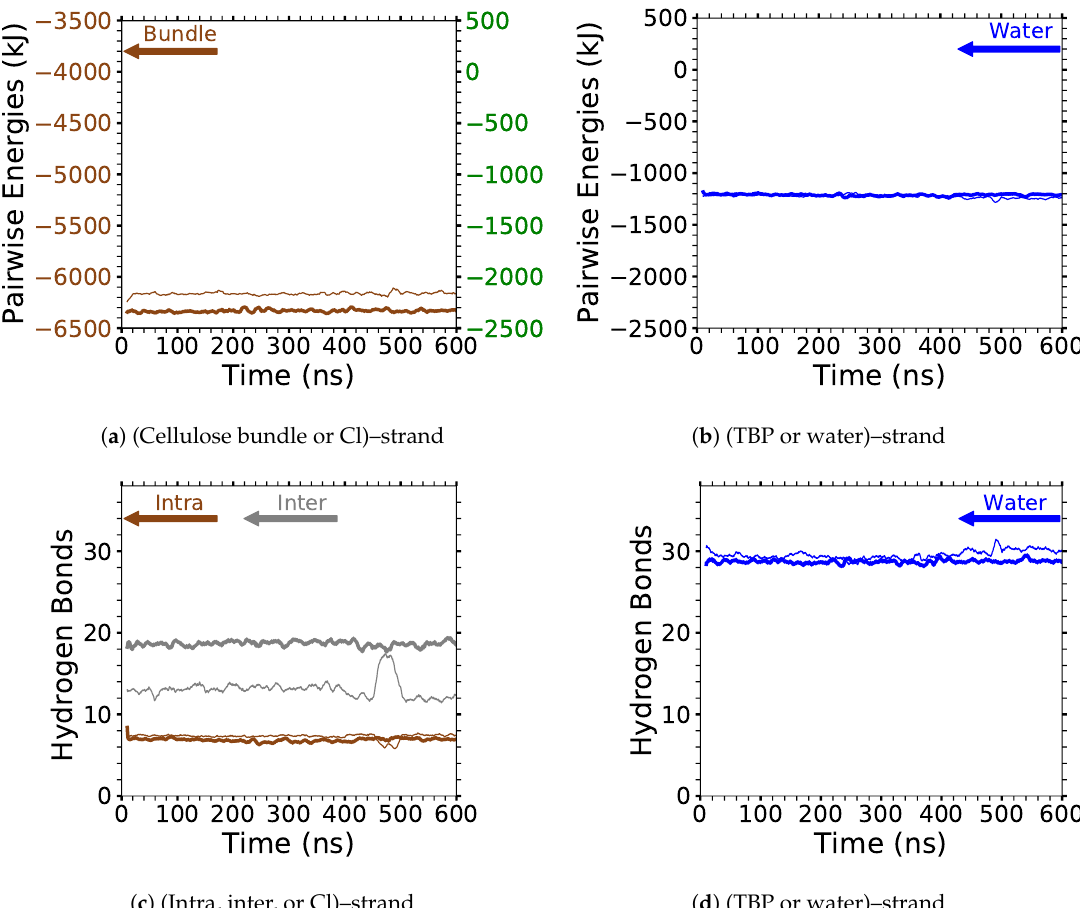
Figure A20. Pairwise energies and hydrogen bonding of the peeling strand(s) at 100mol%water and 360K. The pairwise energies of the separating strand(s) between the: ( a ) (cellulose bundle or Cl)–separating strand; ( b ) (TBP or water)–separating strand. The number of hydrogen bonds for the separating strand(s) per the given type: ( c ) (intra, inter, or Cl)–separating strand; ( d ) (TBP or water)–separating strand. The thick line is the first yellow strand to peel, and the thin line is the non-peeling yellow strand or second strand to peel. If neither of the stands peel, then both the thick and thin lines are non-peeling yellow strands. The data were averaged over 1000 data points, using a rolling